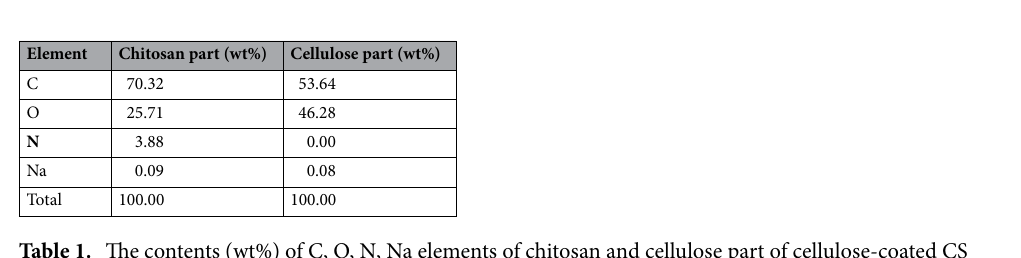
Table 1. The contents (wt%) of C, O, N, Na elements of chitosan and cellulose part of cellulose-coated CS bead analyzed by FE-SEM EDS mapping.